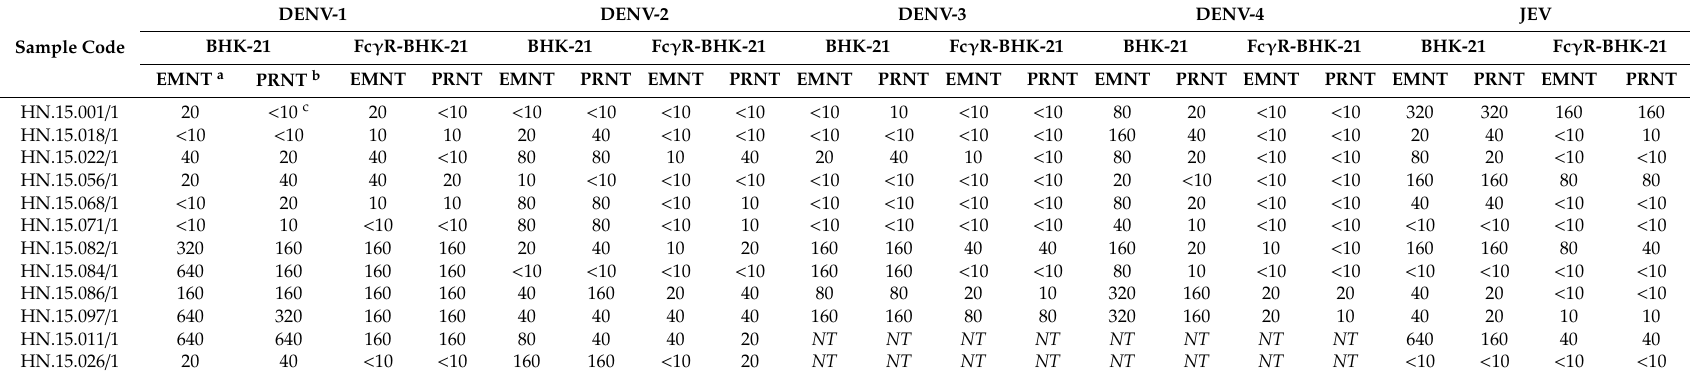
Table 2. Neutralizing Titers of 12 DENV IgG + Clinical Samples Against DENV and JEV Using EMNT and PRNT by Using BHK-21 Cells and Fc γ RIIA-Expressing BHK-21 Cells as Assay